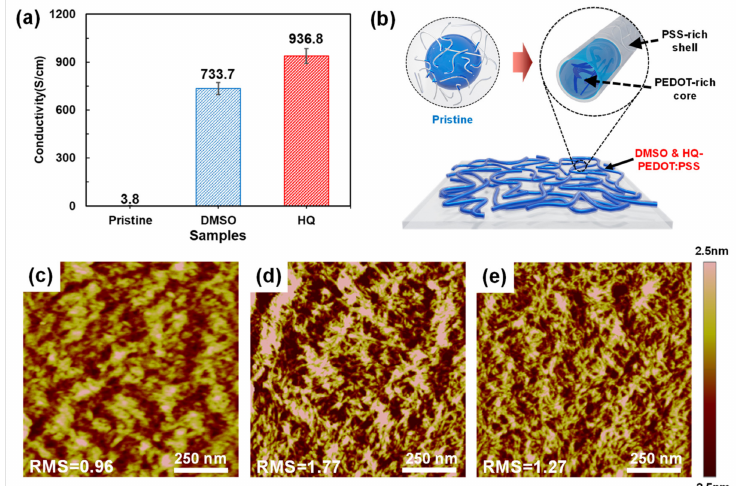
Figure 5. ( a ) Conductivity of various PEDOT:PSS TFs, and ( b ) schematic illustration of the HQ and DMSO effect on core-shell structure breakdown for continuous PEDOT conductive channel formation. AFM images of ( c ) pristine- ( d ) DMSO- and ( e ) HQ-PEDOT:PSS (scan size: 1 µ m × 1 µ